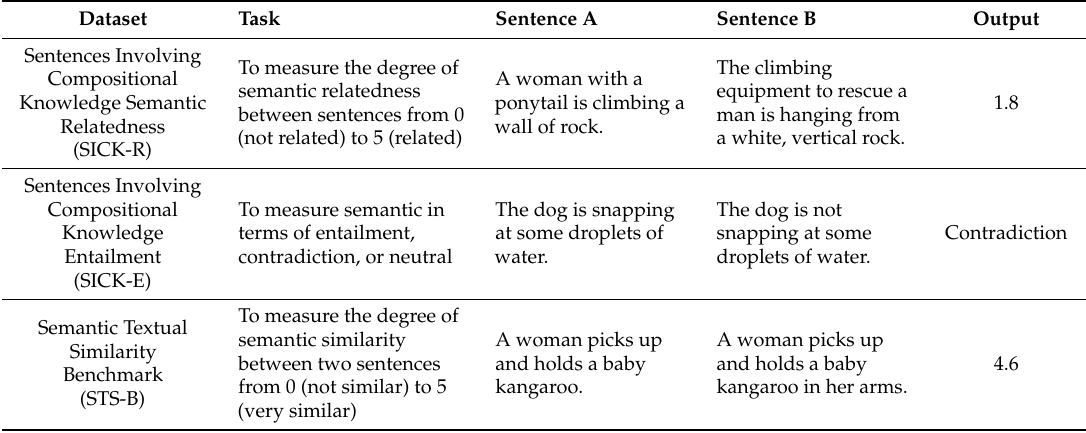
Table 4. Downstream tasks description and